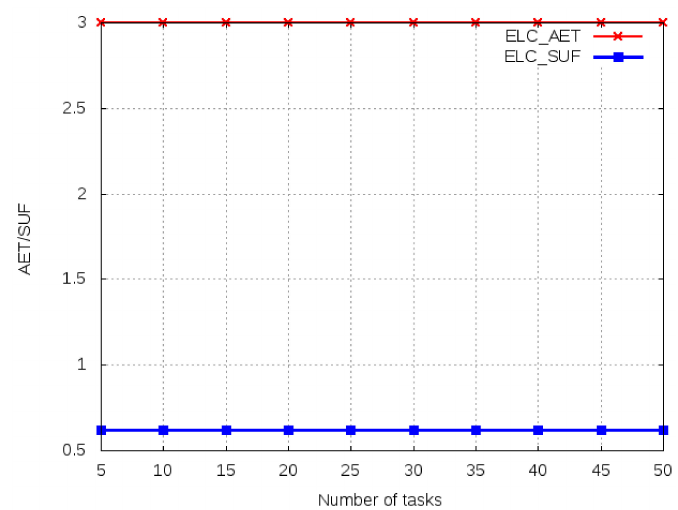
Figure 5. Average execution time and system utility for ELC.